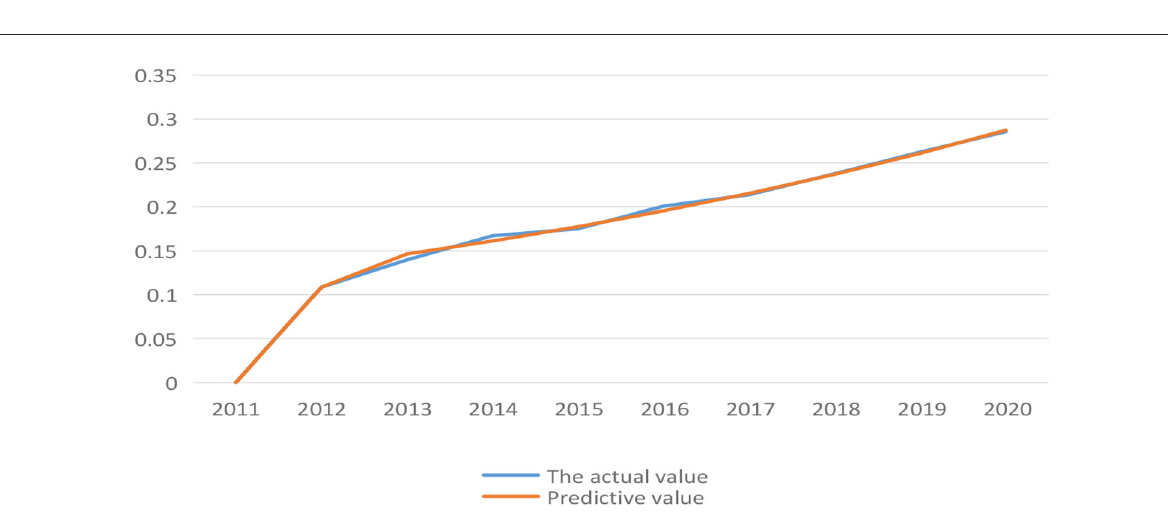
(4) Combined with Eq. 15–21 again, the value